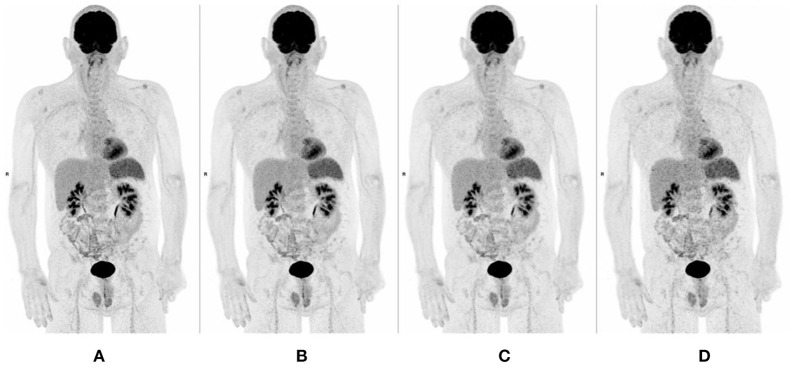
MIP images of a 61 years old man, showing improvement of quality, sharpness, and noise when increasing acquisition time [(A-D) from left to right, respectively, 120, 90, 60, and 30 s per bed position].